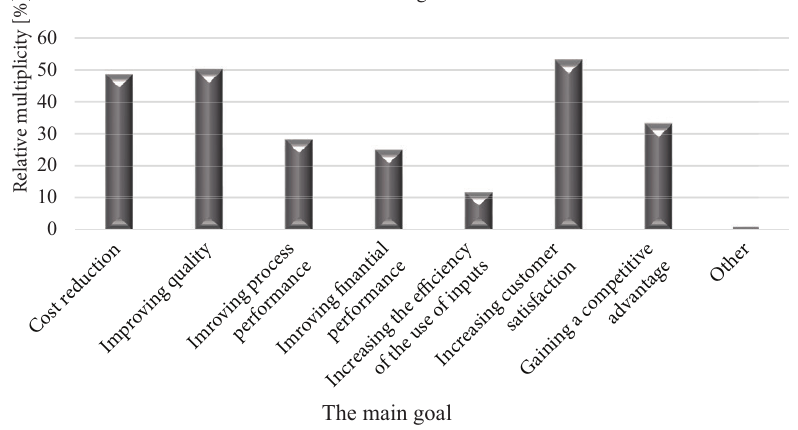
Figure 4. The main goal of the change (source: own